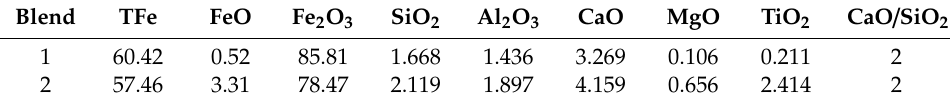
Table 3. Estimated chemical composition of the hematite-ilmenite ore blends (wt%). Blend TFe